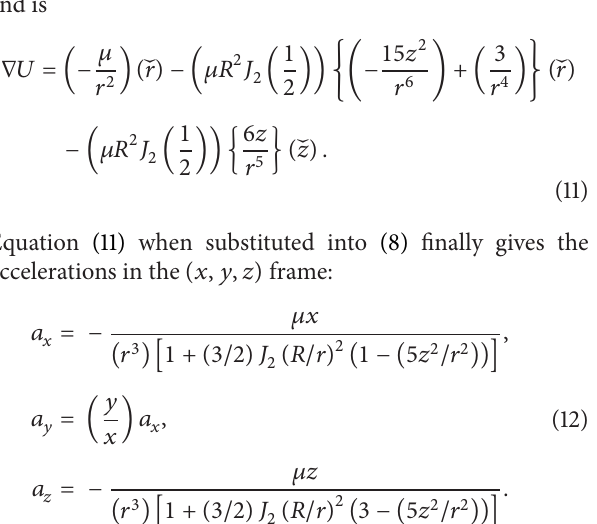
The acceleration is then obtained using the relations in (8) and